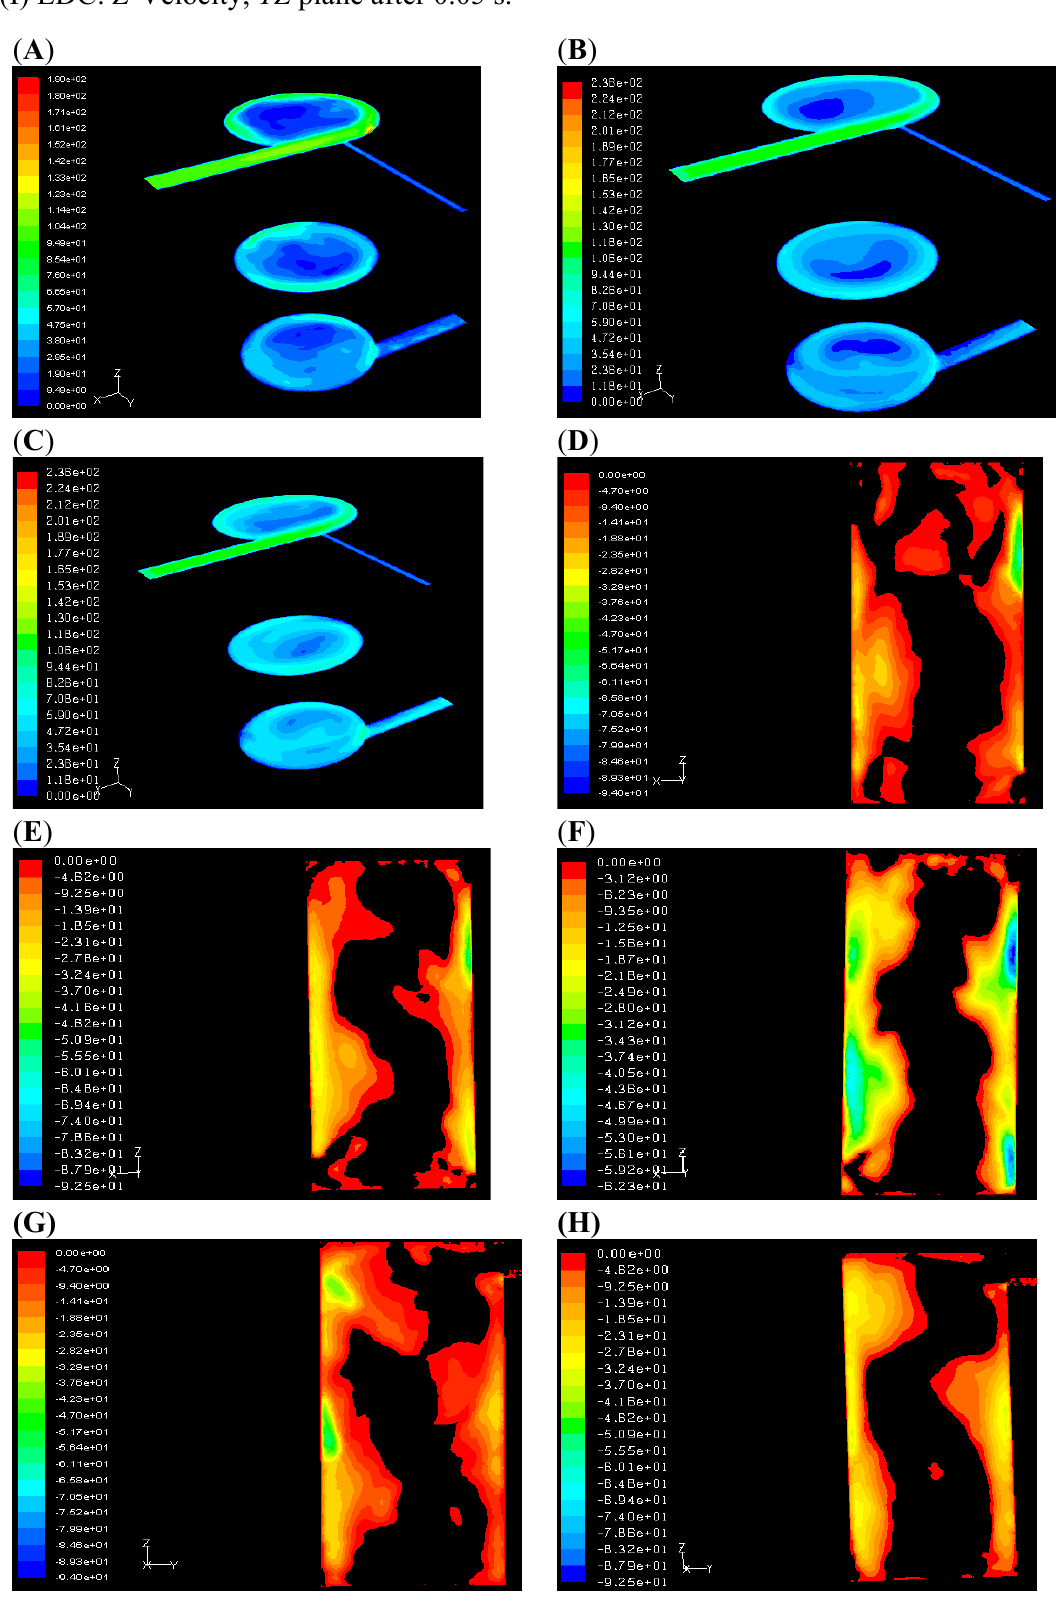
Figure 5. (A) Flamelet: Velocity, t = 0.03 s; (B) EDC: Velocity, t = 0.03 s; (C) EDC: Velocity, t = 0.05 s; (D) Flamelet: Z -Velocity, XZ plane, t = 0.03 s; (E) EDC: Z -Velocity, XZ plane, t = 0.03s; (F) EDC: Z -Velocity, XZ plane, t = 0.05 s; (G) Flamelet: Z -Velocity, YZ plane, t = 0.03 s; (H) EDC: Z -Velocity, YZ plane, t = 0.03 s; (I) EDC: Z -Velocity, YZ plane after 0.05 s. ( A